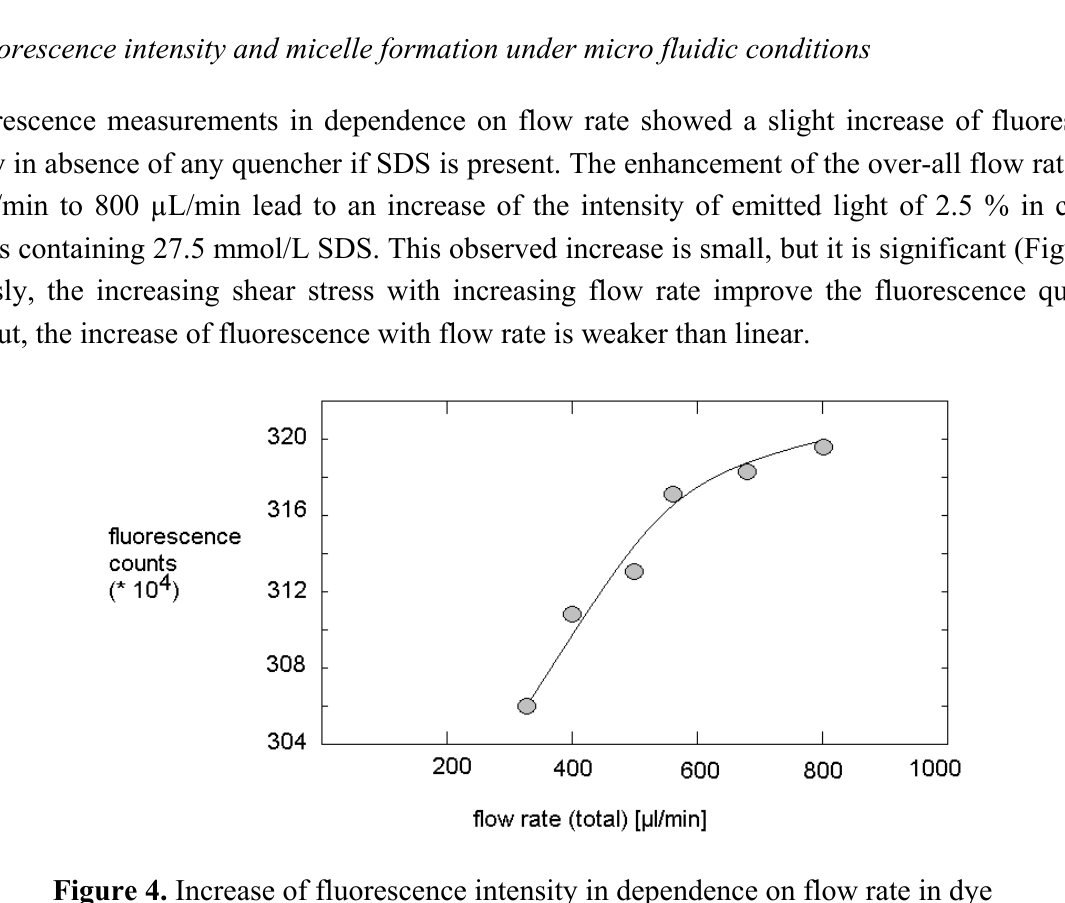
Figure 3. Fluorescence intensity measured inside the PTFE tube in dependence on dye concentration under stationary micro fluidic conditions.